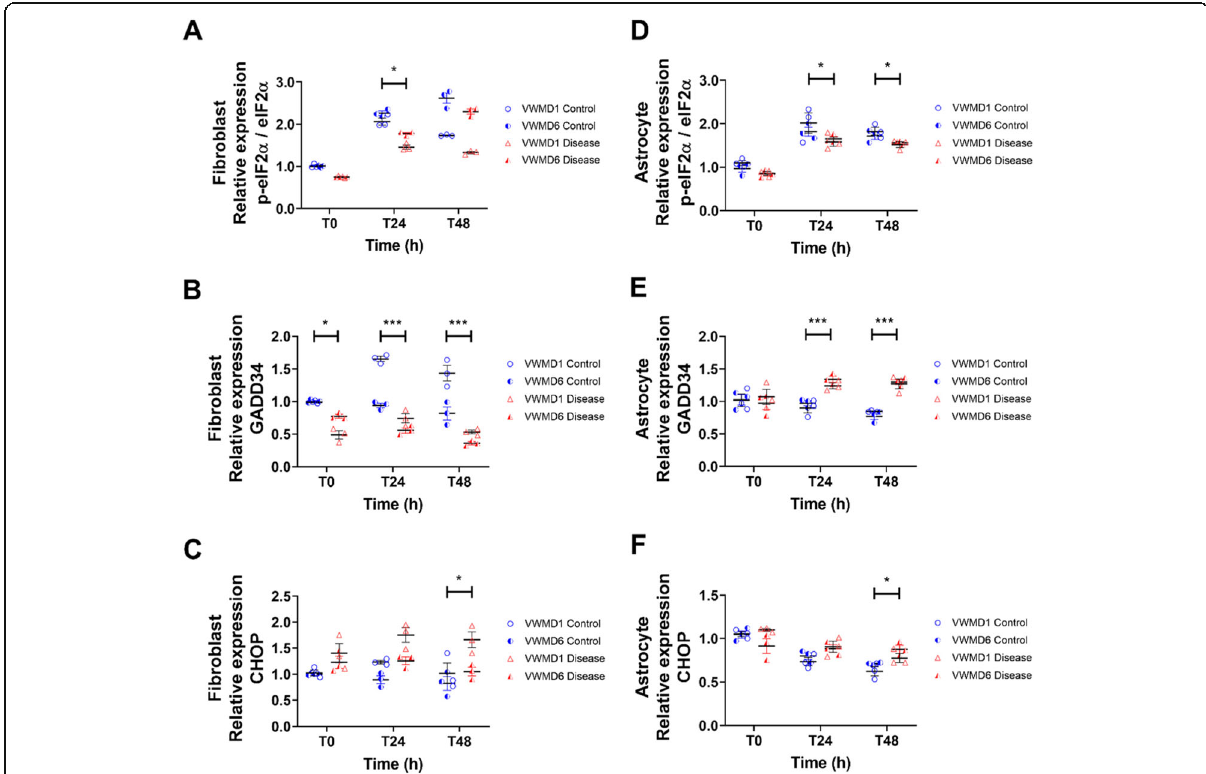
Fig. 1 ISR marker protein expression is affected in VWMD fibroblasts and astrocytes. a - f Effect of MG132 stress on protein expression of the ISR markers, p-eIF2 α (normalised to eIF2 α ), GADD34 or CHOP, at 0, 24 or 48 h incubation period. Protein levels were quantified by western blot, normalised to total protein, and are shown relative to control at time 0. Individual data points are shown from VWMD1 patient EIF2B5 R113H/A403V ; VWMD6 patient EIF2B2 G200V/E213G or their non-disease controls VWMD1 Control EIF2B5 R113/A403 ; VWMD6 Control EIF2B2 G200V/E213 , with mean ± SEM, n = 3. Significant differences between pooled disease and control groups were identified by two-way ANOVA followed by Holm-Sidak post hoc test, * p < 0.05, ** p < 0.01, *** p < 0.001. Representative blots shown in (Figure